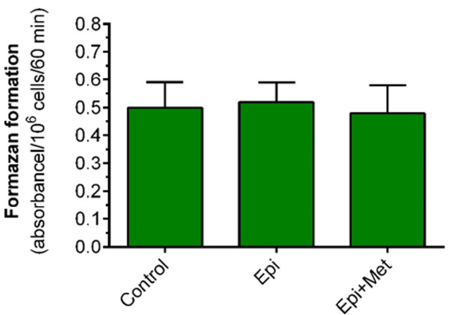
Figure 8. The effects of metformin on the viability of isolated rat adipocytes. Adipocytes were preincubated for 3 h with or without 1 mM metformin in buffer containing 3 mM glucose. Then, 0.5 µM epinephrine or 1 mM metformin was added and incubations were performed for an additional 1 h. Then, all cells were washed with the buffer without metformin and were incubated in the buffer containing 3 mM glucose with 0.5 mg/mL MTT. After 1 h of incubation, isopropanol was added, and tubes were shaken and centrifuged. Afterward, the formazan content was determined. Epi— epinephrine, Met—metformin, MTT—3-(4,5-dimethylthiazol-2-yl)-2,5-diphenyltetrazolium bro- mide. The obtained results represent the mean ± SEM from 3 independent experiments in 5 repeti- tions ( n = 15).